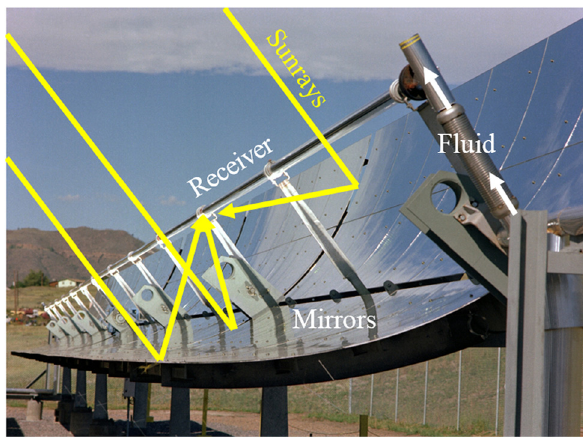
Figure 2: Parabolic trough collector system. ( Retrieved from the NREL website: https://images.nrel.gov. )